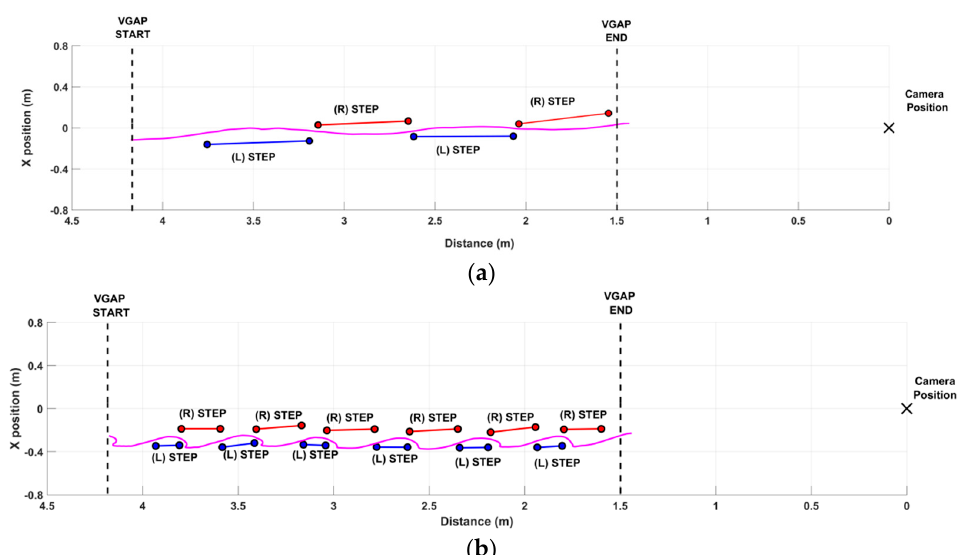
Figure 7. Examples of gait analysis with the step segmentation algorithm. ( a ) Example of a good performance: two steps for both the legs within the VGAP. The COM HIP trajectory (solid magenta line) shows small excursions, denoting relatively good body control during walking. ( b ) Example of a significantly impaired performance, characterized by shorter steps and higher body sway, indicating the attempt to compensate for impairment during walking. Table 4. Spatiotemporal parameters for the paretic and non-paretic sides of gait patterns shown in Figure